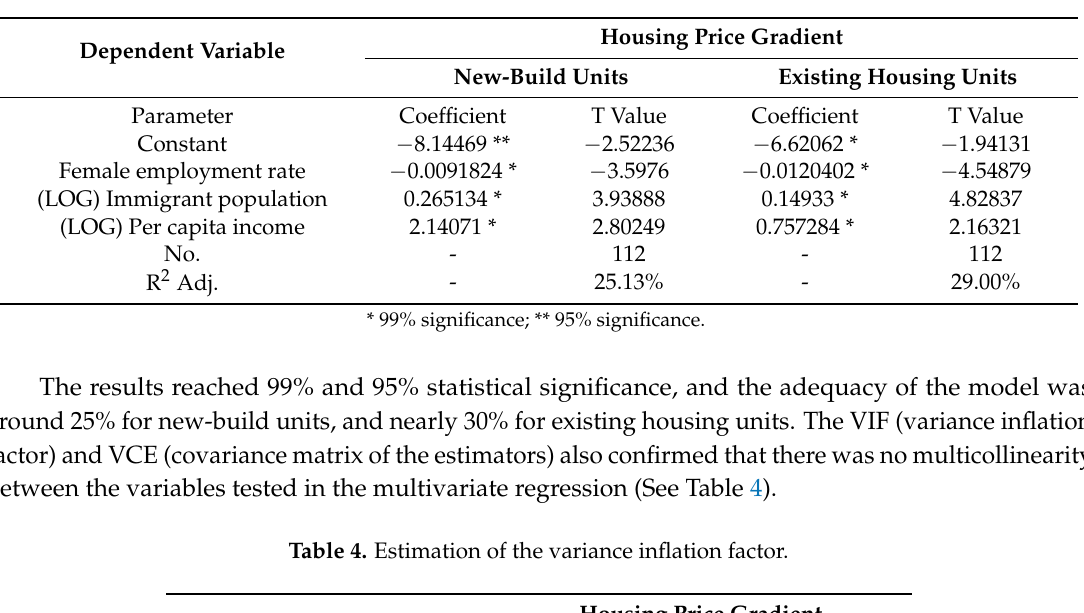
Table 3. Estimation of housing price gradients for new-build and existing units.